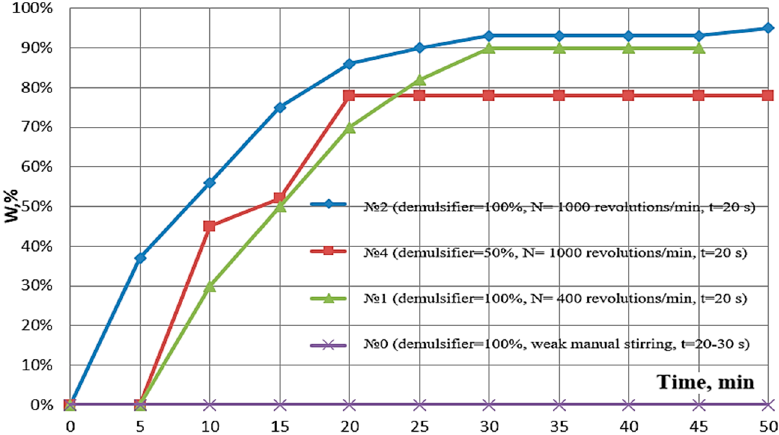
Figure 10. Dependence of the value W (%) on the speed of the hydraulic flow during the introduction of the demulsifier (W/O = 67%, T = 32 ° С